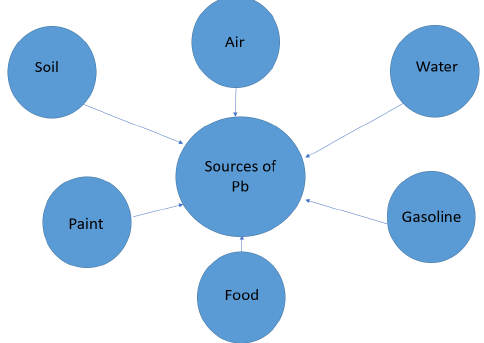
Figure 1. Sources of lead exposure found in this commentary.